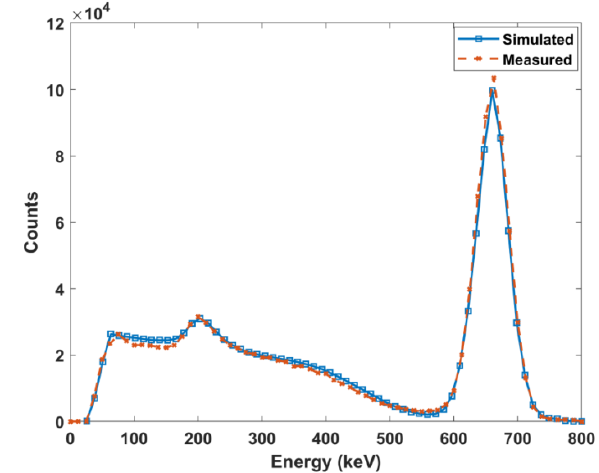
Figure 3. Comparison of measured and simulated spectra of 137 Cs.